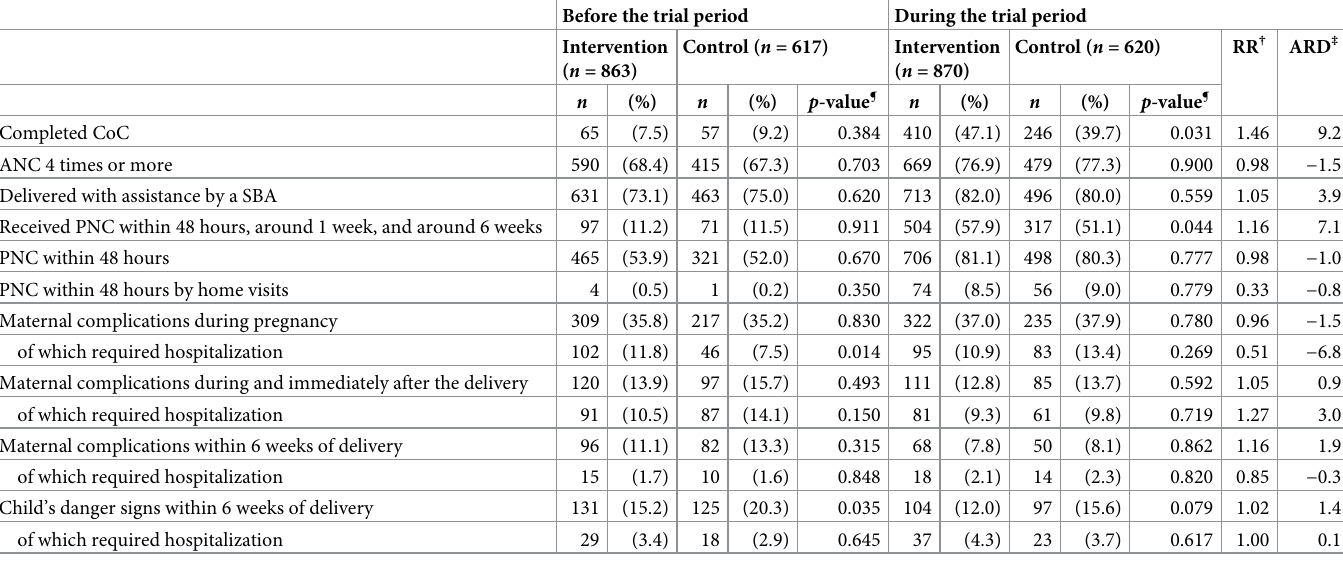
Table 2. Health service and morbidity outcomes of this study.